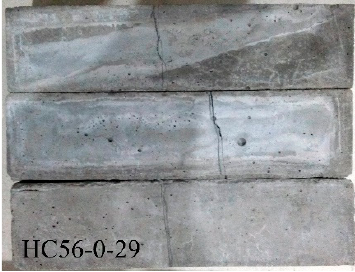
Figure 4. Failure pattern of the control specimens.